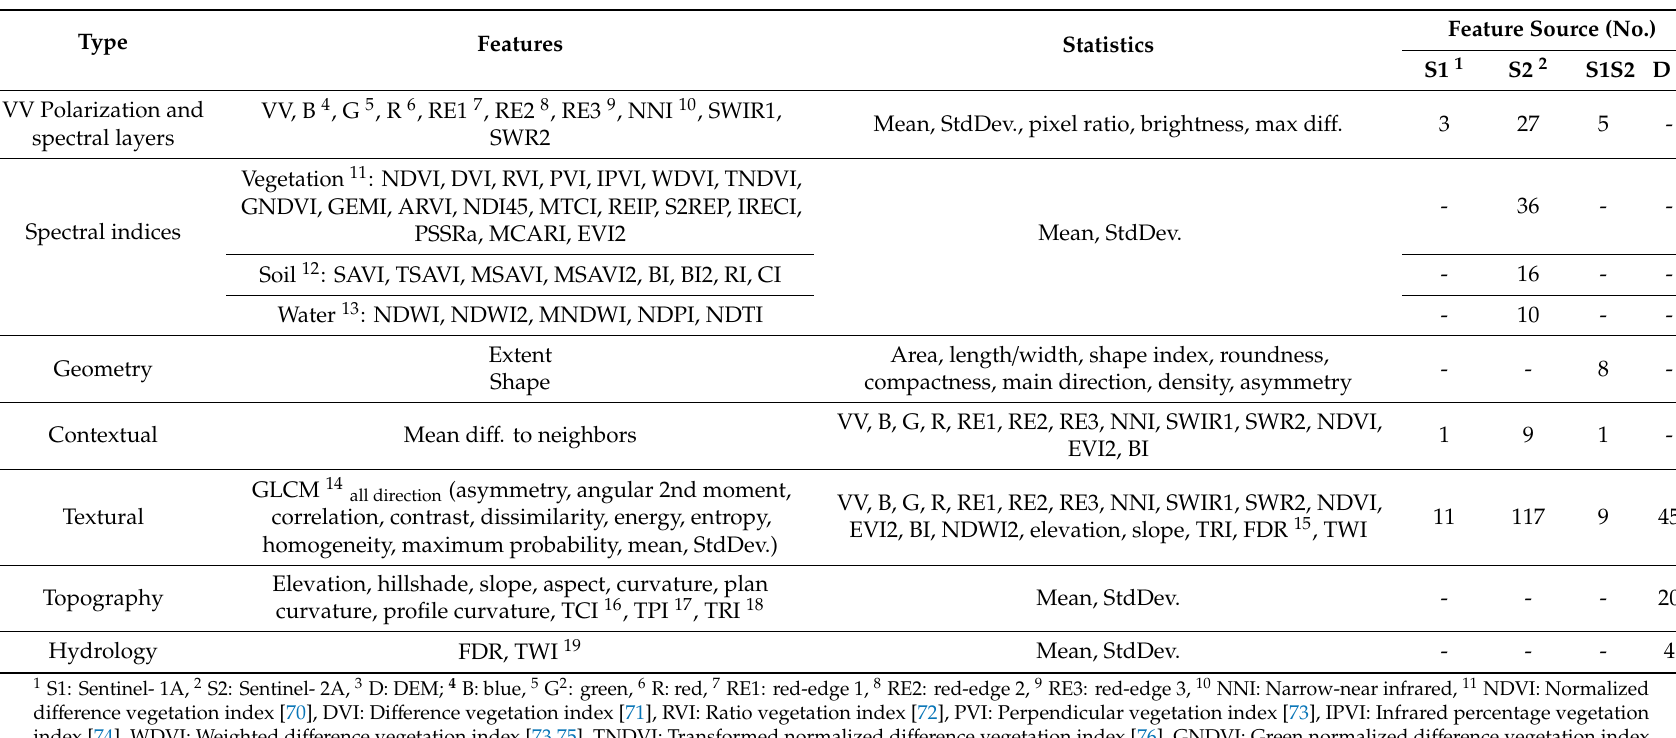
Table 1. Object features derived from Sentinel-1 and -2A as well as digital elevation model (DEM) for landslide mapping in NE,